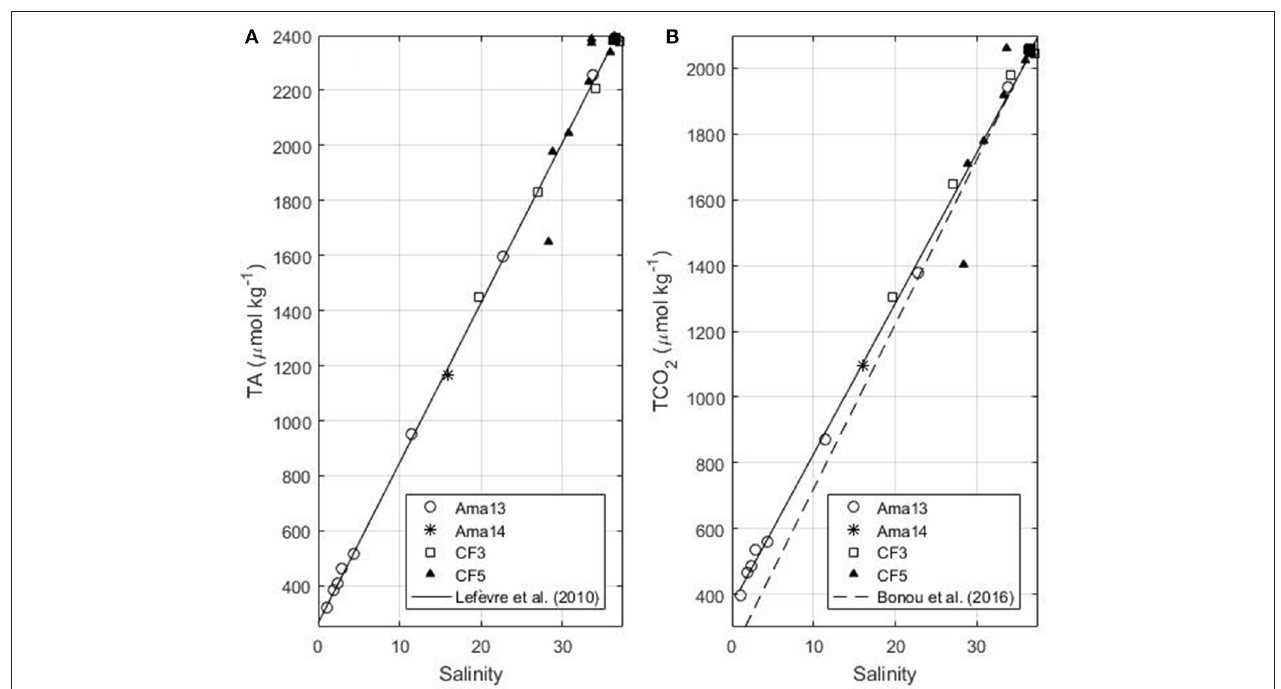
FIGURE 2 | (A) TA as a function of salinity in the Amazon continental shelf (isobaths < 100 m) for the Amazon transects of April 2013 and May 2014 and the Camadas Finas 3 (October 2012) and 5 (September 2014) cruises. The black line corresponds to the fit using the April 2013 data (Equation 2 in the text, the relationship determined by Lefèvre et al., 2010). (B) TCO 2 as a function of salinity for the same cruises (Equation 3 in the text). The dash line represents the Equation determined by Bonou et al.